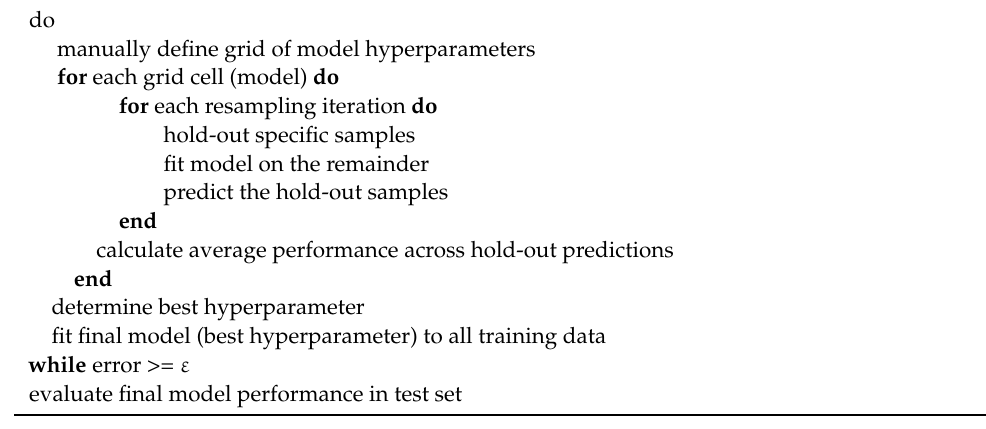
Algorithm 1 Pseudocode for the iterative grid-based training process